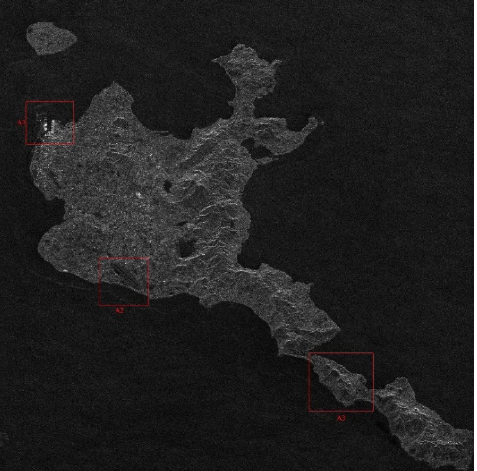
Figure 16. The result of Sentinel-1 radar azimuth full sampling data using RD algorithm (vertical range, horizontal azimuth).